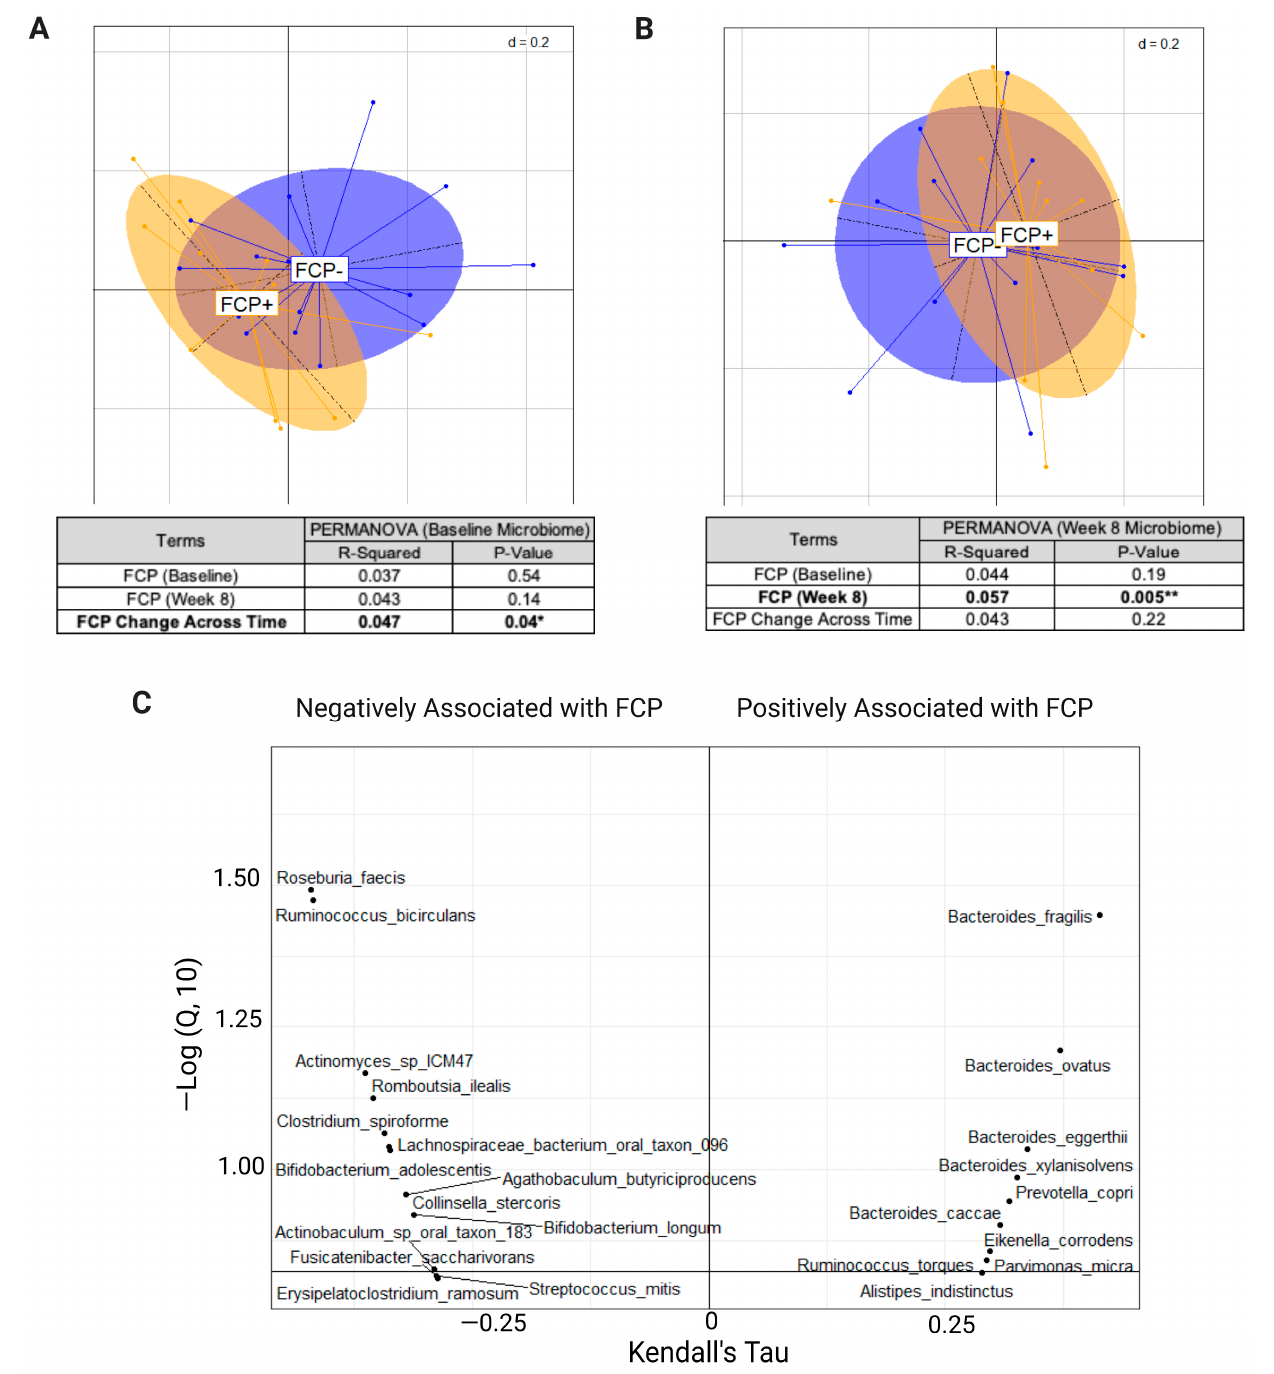
Figure 2. Associations between fecal calprotectin (FCP) and the microbial taxa. ( A ) PCoA plot of baseline microbiome profiles of participants that had an increase in FCP (FCP+; orange) vs. a decrease in FCP (FCP − ; blue) from baseline to week 8. PERMANOVA values of the association of baseline microbiome with baseline FCP, week 8 FCP and change in FCP are indicated below the figure. ( B ) PCoA plot of week 8 microbiome profiles of participants that had an increase in FCP (FCP+; orange) vs. decrease in FCP (FCP − ; blue) from baseline to week 8. PERMANOVA values of the association of week 8 microbiome with baseline, week 8 FCP and change in FCP are indicated below the figure. ( C ) Identification of the specific species of microbes associated with fecal calprotectin at week 8. Asterisks indicate the significance level: ** p < 0.01, * p < 0.05. Abbreviations: FCP, fecal calprotectin; PCoA, principle coordinate analysis; PERMANOVA, permutational multivariate analysis of